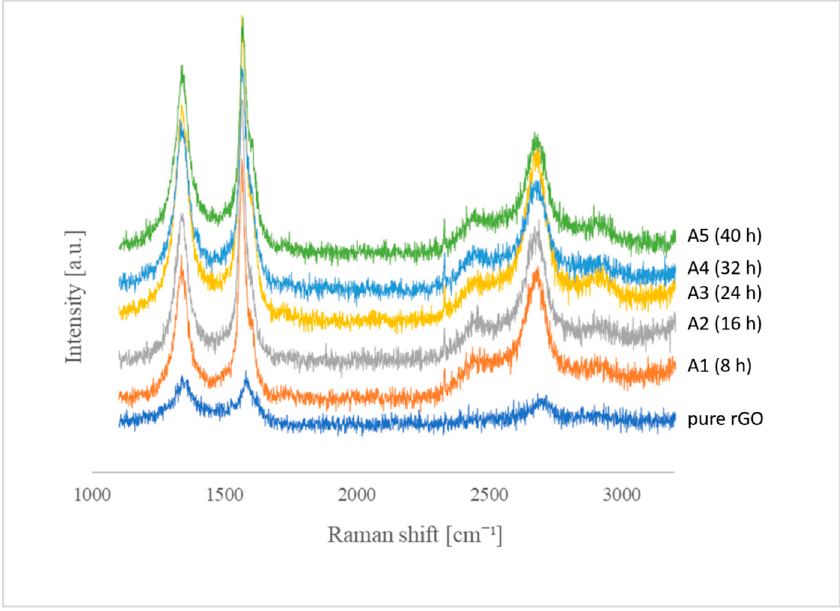
Figure 5. Summary of Raman spectra for the material before modification (rGO) and the obtained end products (samples A1–A5).